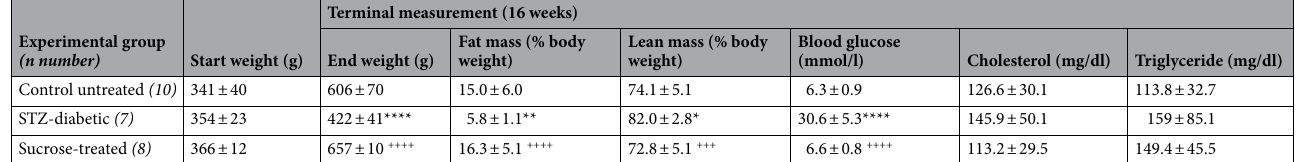
Table 1. Metabolic indices: STZ-diabetic rats developed hyperglycaemia and were significantly lighter than untreated rats 16 weeks post-STZ. The sucrose-treated group did not develop hyperglycaemia or hyperlipidaemia and were not significantly different in body weight or composition (% fat/lean mass, assessed by Echo MRI) from the untreated control rats after 16 weeks. Data represent mean ± standard deviation. Statistical analysis was conducted using one-way ANOVA followed by Tukey’s post hoc test (*) denotes the comparison with the untreated control group and (+) denotes the comparison with diabetic rats (* p <